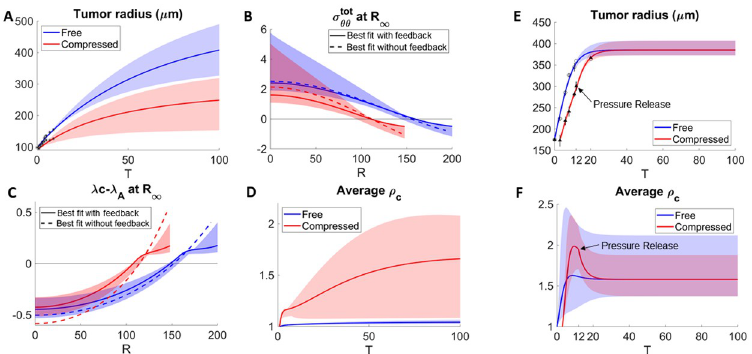
Fig 4. Fitting the model to data from [12, 13] of tumor spheroids grown free or with external pressure, with and without (dashed) feedback from the elastic stress (A). External pressure is released at the time reported in [13] (E). Bands show the results within 10% of the best fit with feedback in all panels. (B) and (C): The distributions of stresses and net volume growth rates from the model. (D) and (F): Average cell density of tumors in (A) and (E) respectively. See S4 Text for the list of